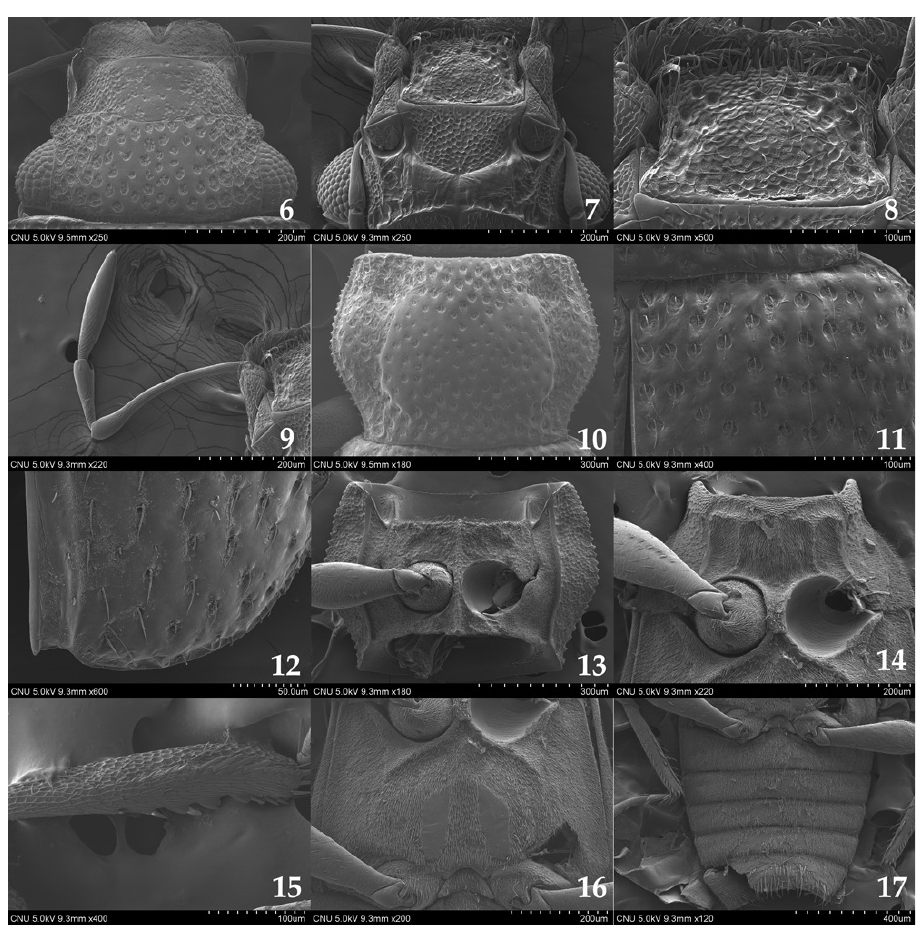
Figures 6–17. Hydraena puetzi . 6 head (dorsal aspect) 7 head (ventral aspect) 8 mentum (ventral aspect) 9 maxillary palpus (ventral aspect) 10 pronotum (dorsal aspect) 11 anterior part of elytron (dorsal aspect) 12 posterior part of elytron (dorsal aspect) 13 prosternum (ventral aspect) 14 mesoventrite (ventral aspect) 15 mesotibia in male (dorsal aspect) 16 metaventrite (ventral aspect) 17 abdominal sternites (ventral